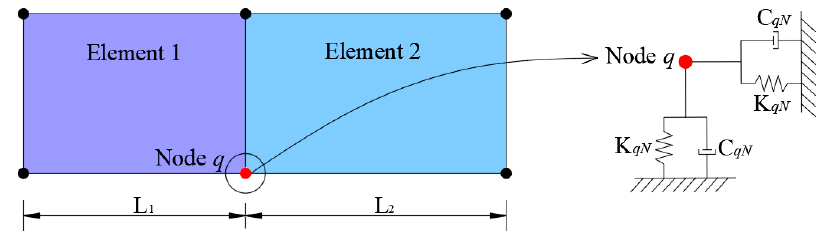
Figure 1. Schematic diagram of a two-dimensional spring-damping element.